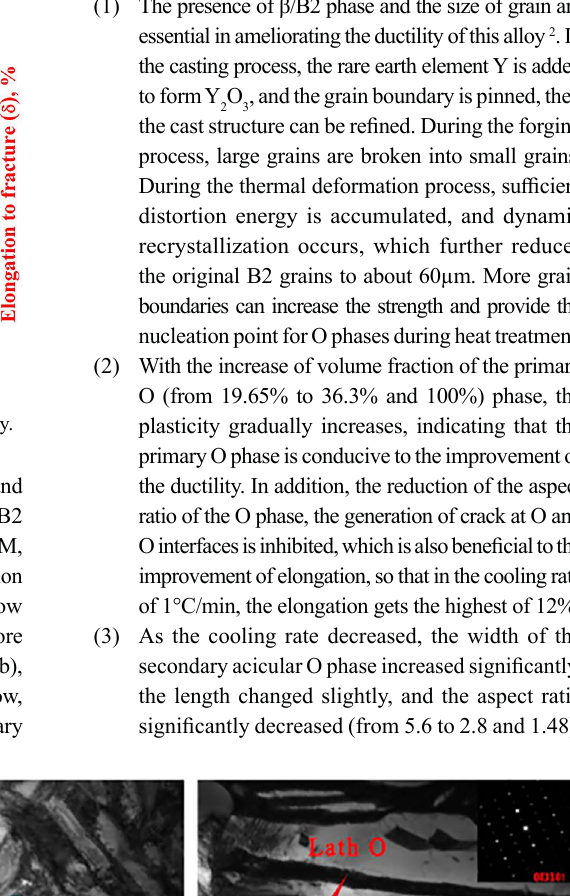
Figure 5. Bright-field TEM images of current forged Ti